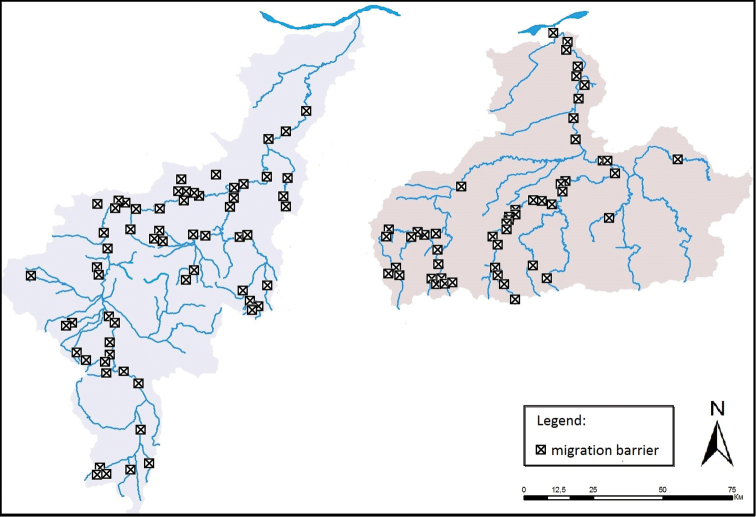
Migration barriers along Iskar (left) and Yantra (right) river catchments (data source: Basin Directorate Danube Pleven 2016).